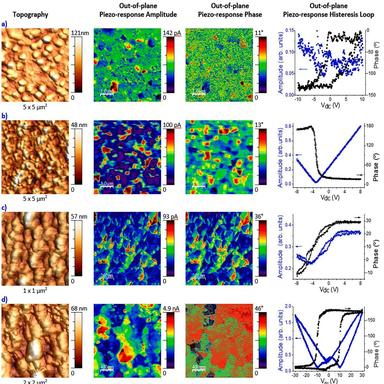
Local piezo-response scanning force microscopy of surface topography (1st column), corresponding out-of-plane amplitude and phase (2nd and 3rd columns) and typical hysteresis curves (4th column) obtained as function of bias voltage spectroscopy for BZT thin films samples: a) deposited at 80 W in O2:Ar = 25%, 350º C for 60 min and b) further annealed at 550º C for 60 min in 1 bar O2; c) deposited at 80 W O2:Ar = 25%, 500º C for 60 min; d) deposited at 75 W, 555º C for 60 min in O2:Ar = 40%.